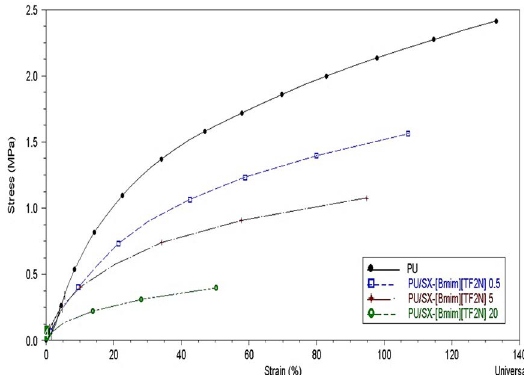
Figure 7. Stress/strain curves obtained for PU and PU composites.